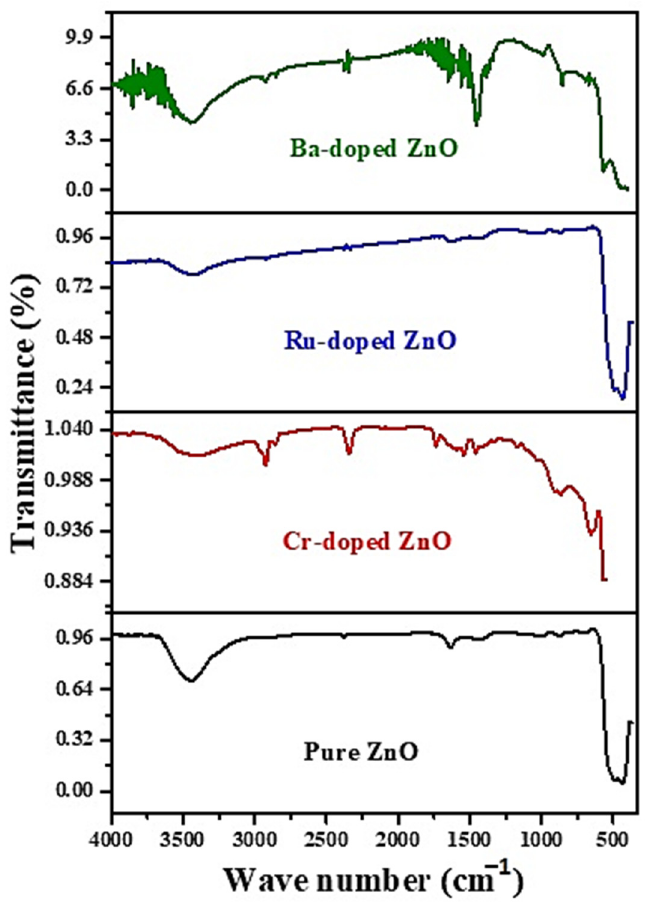
Figure 3. FTIR spectrum of the ZnO, CrZnO, RuZnO, and BaZnO